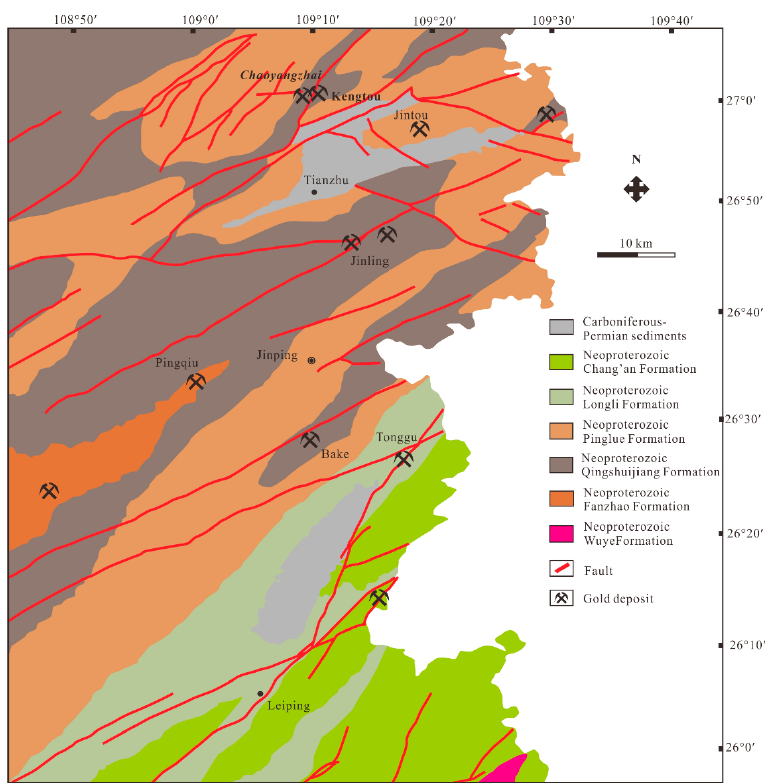
Figure 2. Geological map of the Southeast Guizhou, showing the location of Precambrian rocks, gold deposits (modified from [8,26]).